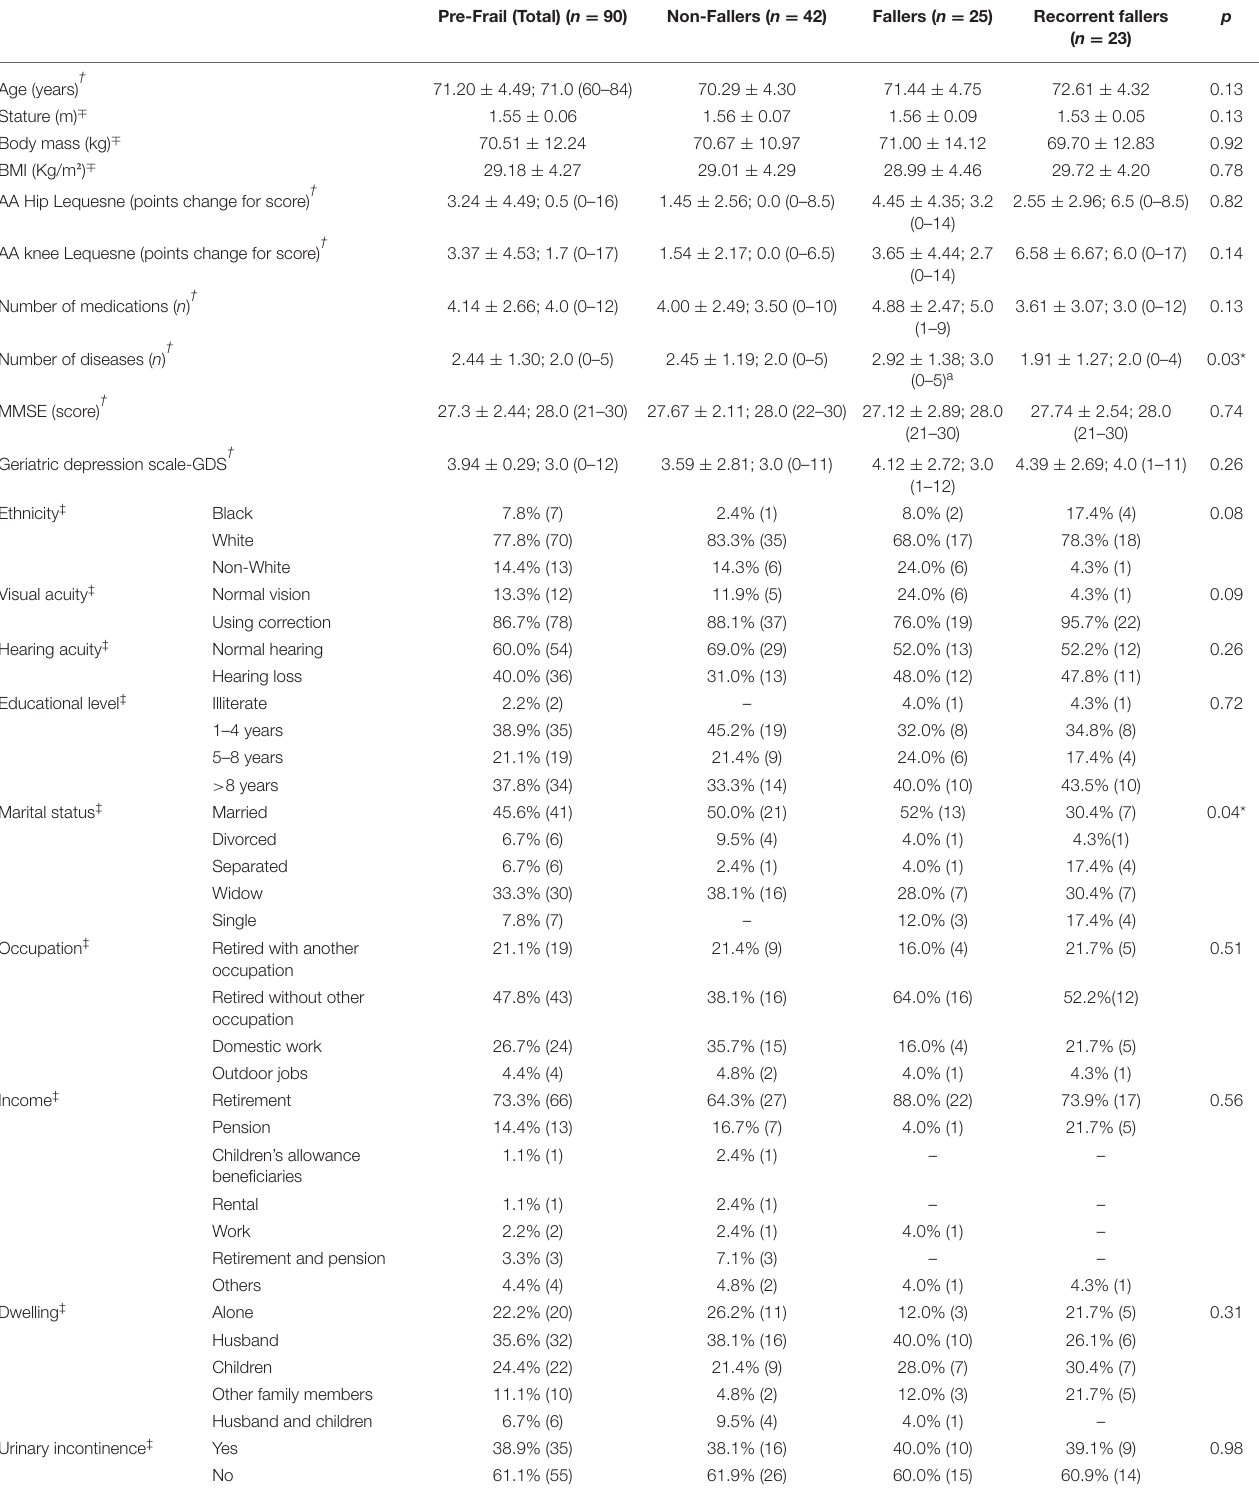
TABLE 1 | Comparison of the clinical, anthropometric, and sociodemographic characteristics and distributions of pre-frail non-fallers, fallers, and recurrent fallers older